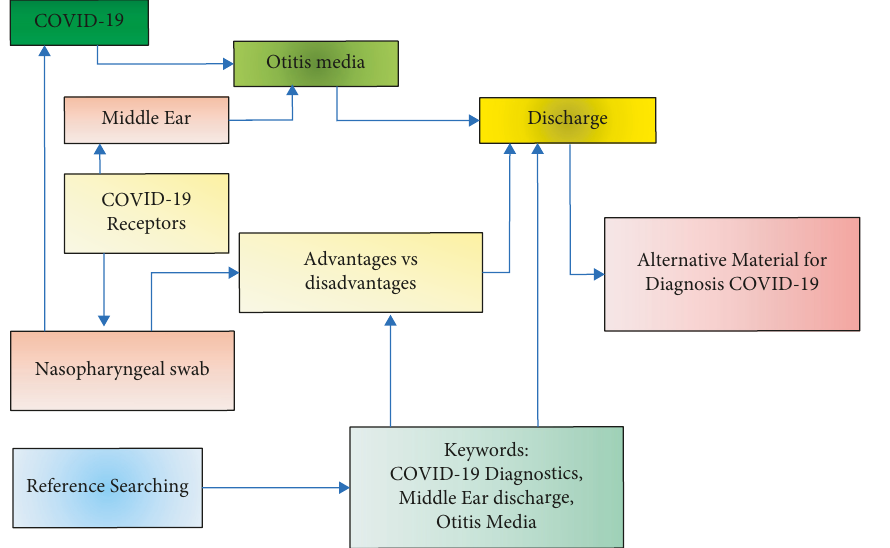
Figure 2: Schematic diagram on measuring potency of the middle ear discharge to be alternative material for COVID-19